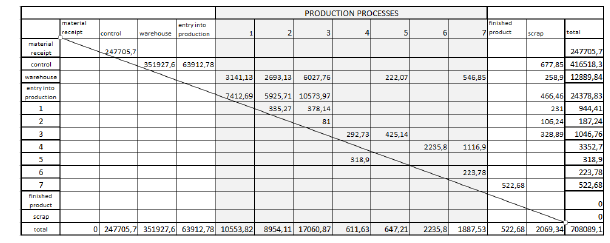
Table 2: Material handling costs in CZK